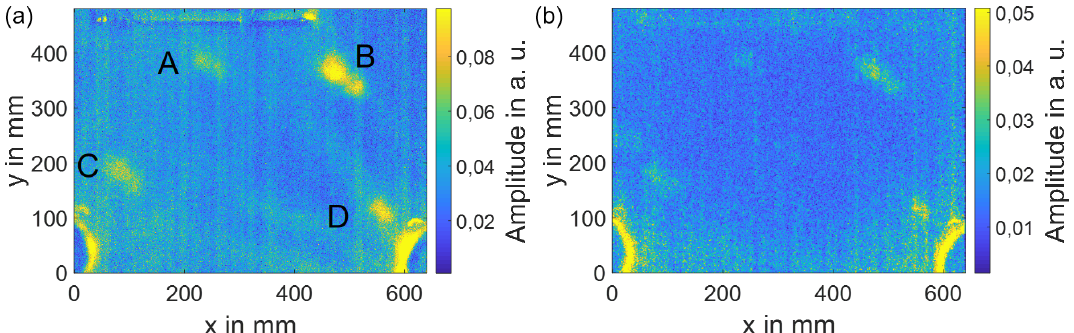
Figure 6. RFST results on an impacted specimen at a 18–25kHz frequency sweep (a) and 10–40kHz frequency sweep (b) . A–D indicate impact damage for a CFRP car roof. The two artifacts in the lower corners indicate the positions of piezo